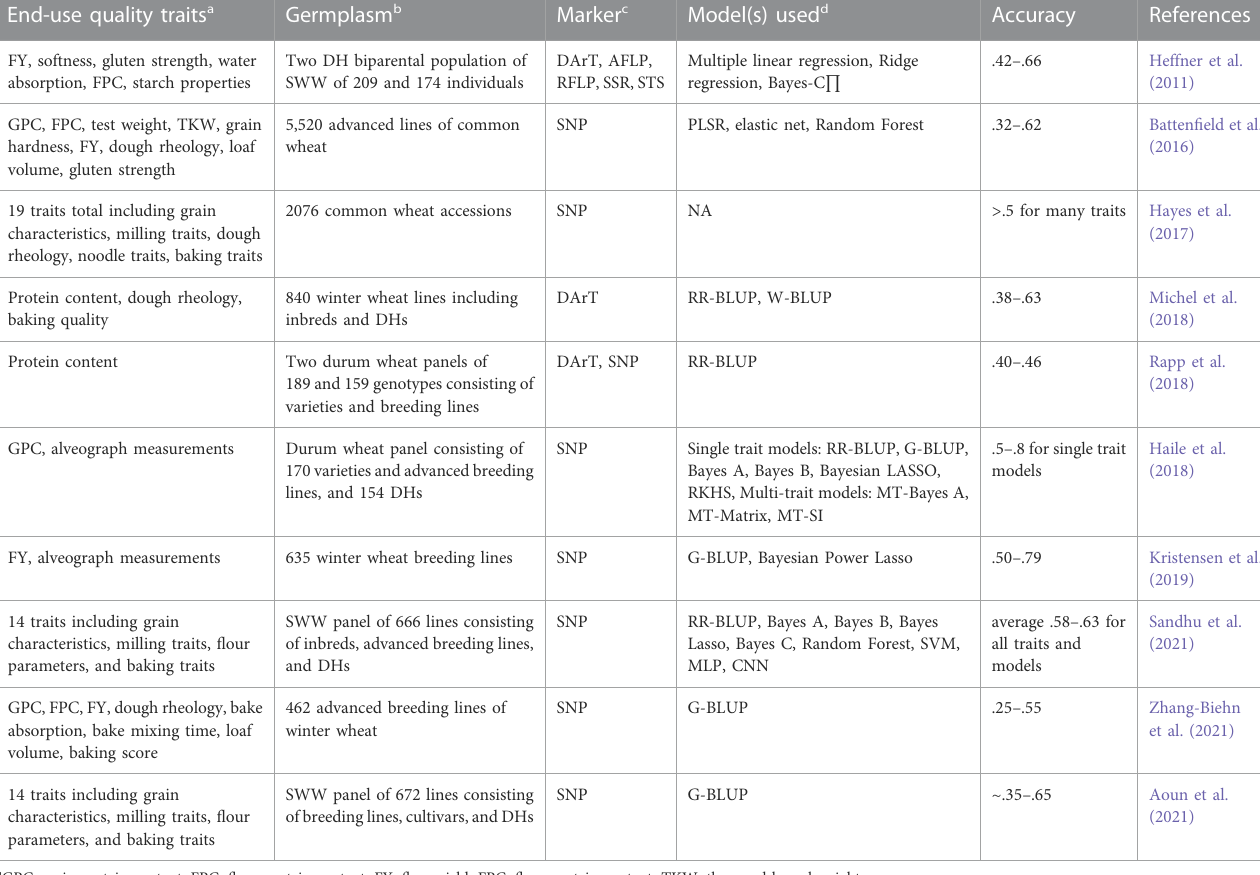
TABLE 3 Summary of few representative genome-based prediction studies for end-use quality traits in